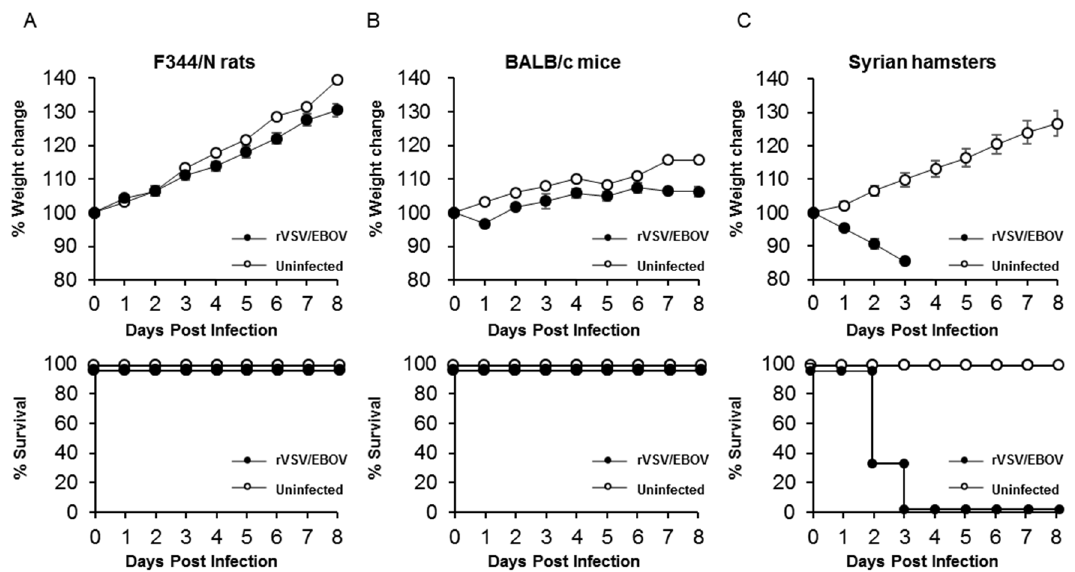
Figure 1. Body weight changes and survival curves of animals after rVSV / EBOV infection. ( A ) F344 / N rats, ( B ) BALB / c mice, and ( C ) Syrian hamsters (3 animals for each group) were injected intraperitoneally (i.p.) with 10 7 , 10 6.5 , and 10 7.2 PFU of rVSV / EBOV, respectively. The symbols represent mean group weights and the bars represent standard errors.